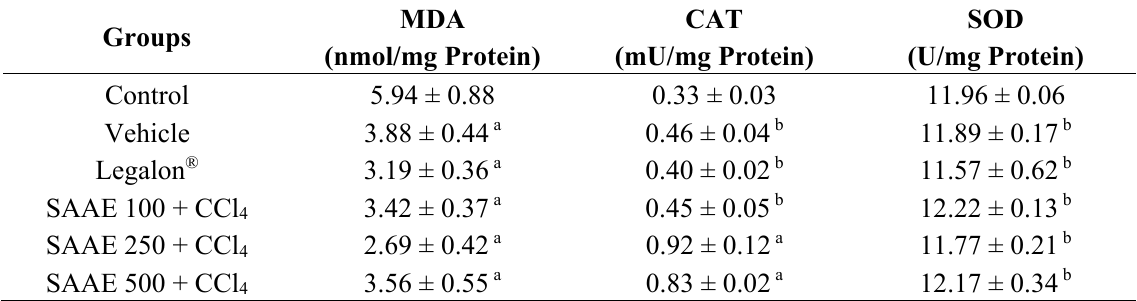
Table 1. Effects of the aqueous extract of Simarouba amara stem bark (SAAE) on lipid peroxidation, catalase and superoxide dismutase levels in Wistar